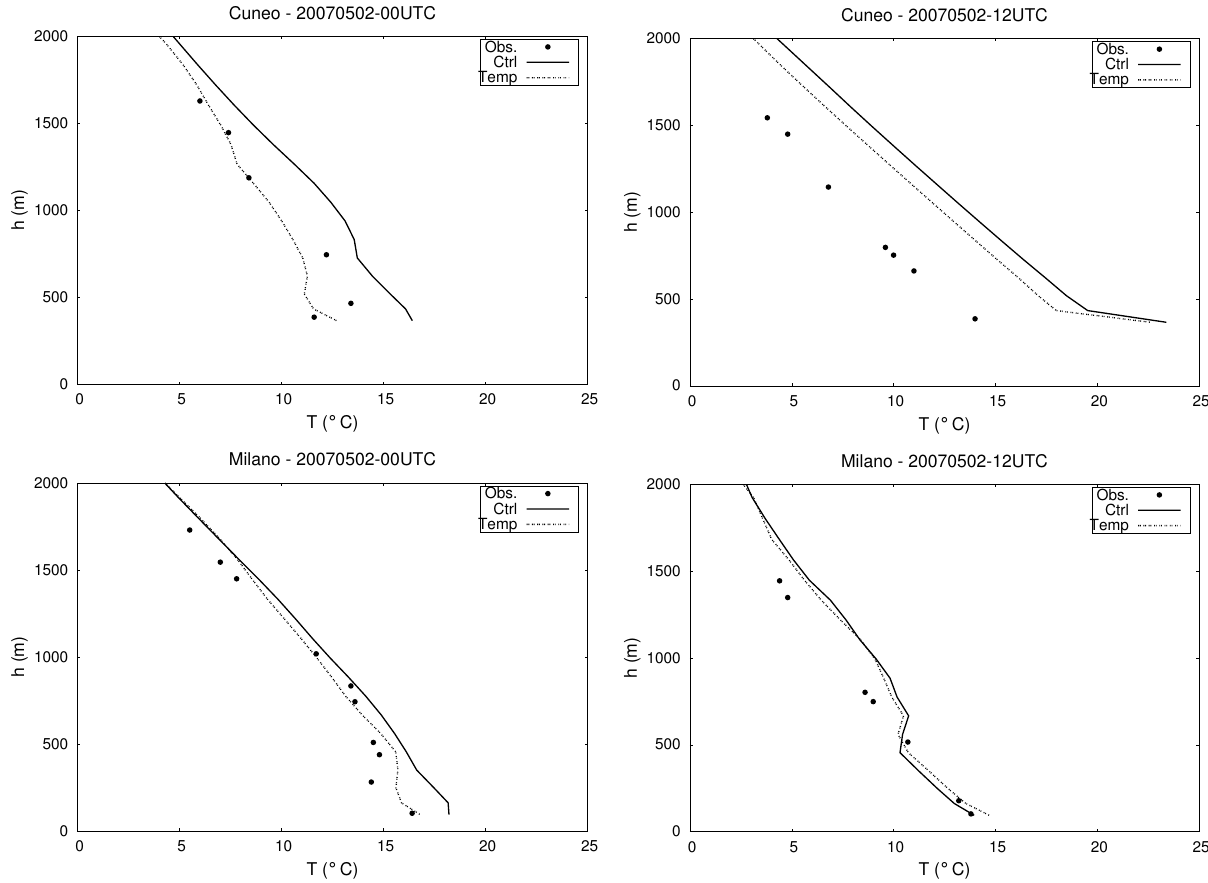
Fig. 15. Vertical temperature profile in Cuneo (above) and Milano (below), at +12h (left) and +24h (right) for the May 2007 case. The dots represent the observations, the continuous line represents the Ctrl run and the dotted line represents the Temp run.